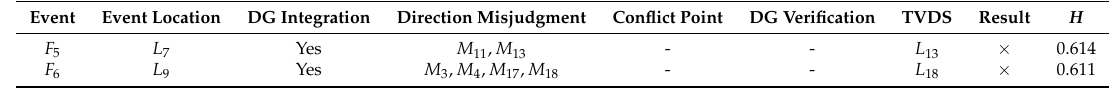
Table 6. Two typical tests of failure for TVDS